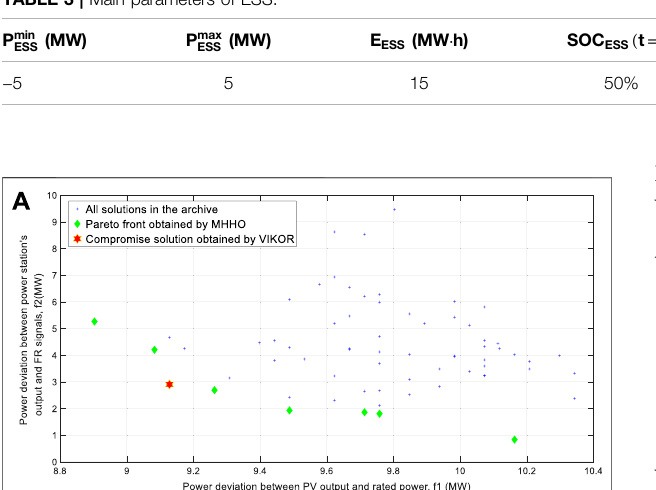
TABLE 3 | Main parameters of ESS.